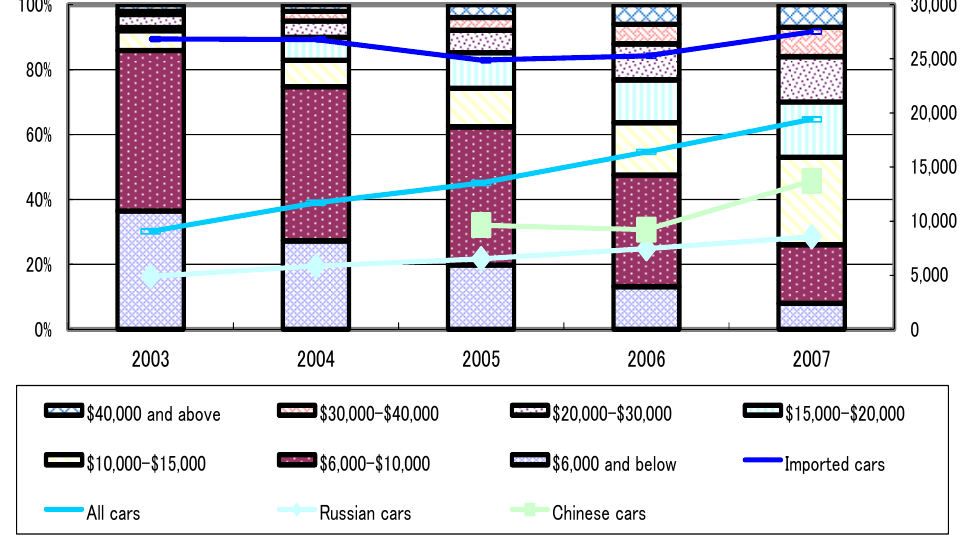
Figure 3. Composition of car types and average price range in the Russian market (unit: